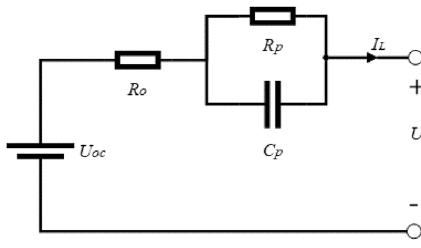
Figure 1. Thevenin equivalent circuit